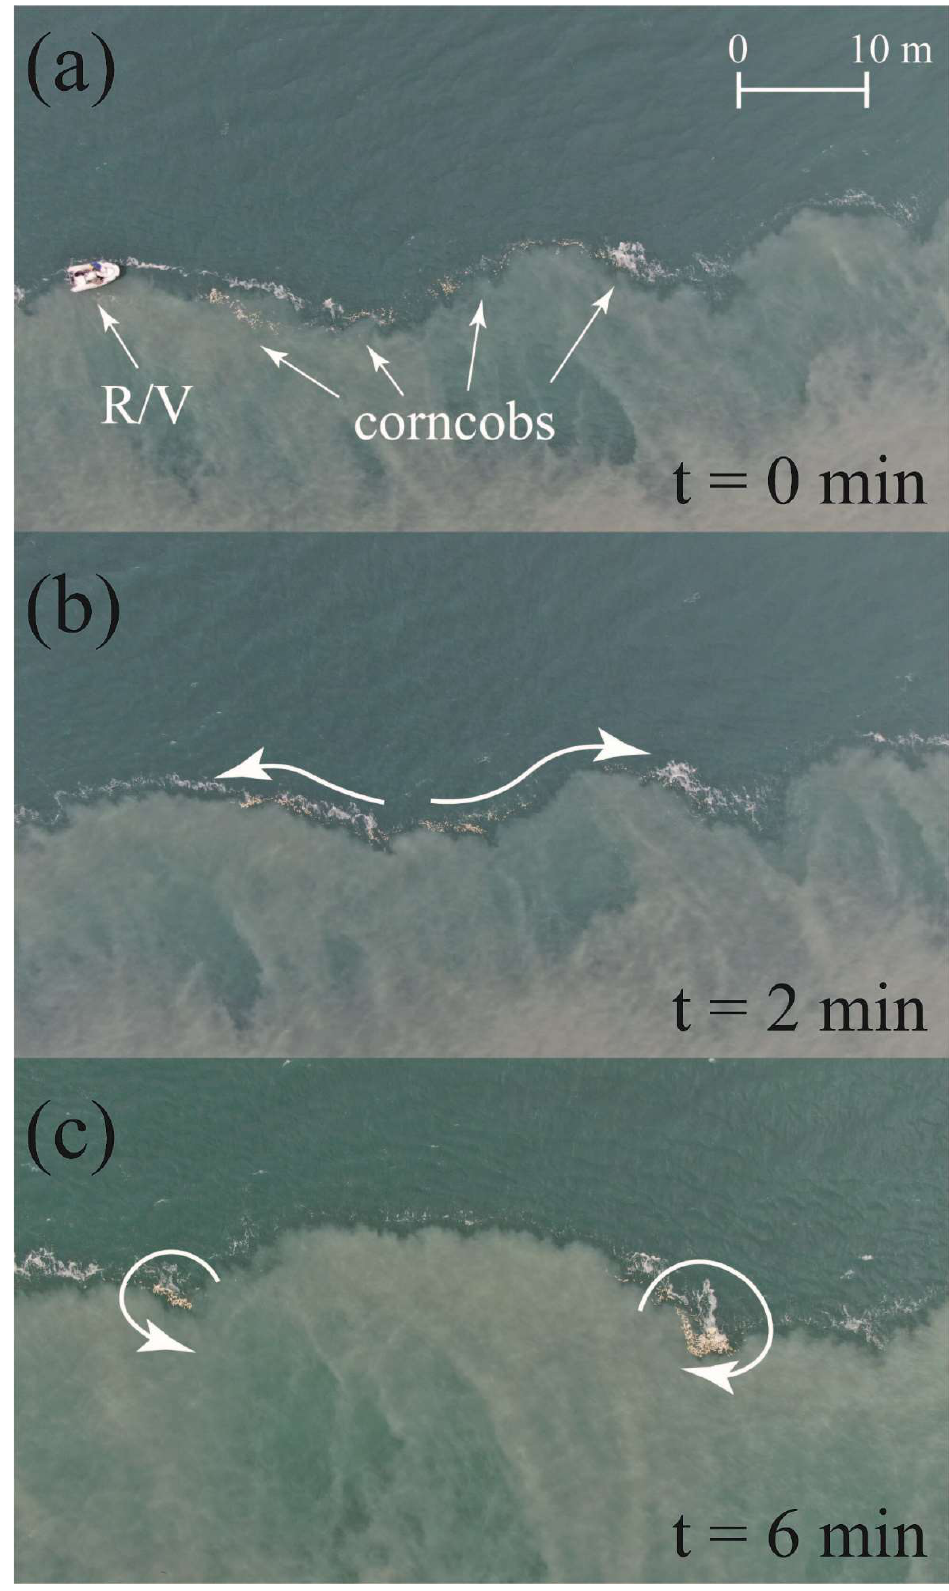
Figure 8. Aerial image of the far-field part of the Bzyb plume border illustrating motion of corncobs on 30 April 2022 at ( a ) the beginning of the “along-border” experiment, ( b ) after 2 min, and ( c ) after 6 min. White arrows in panels ( b , c ) indicate motion of corncobs.